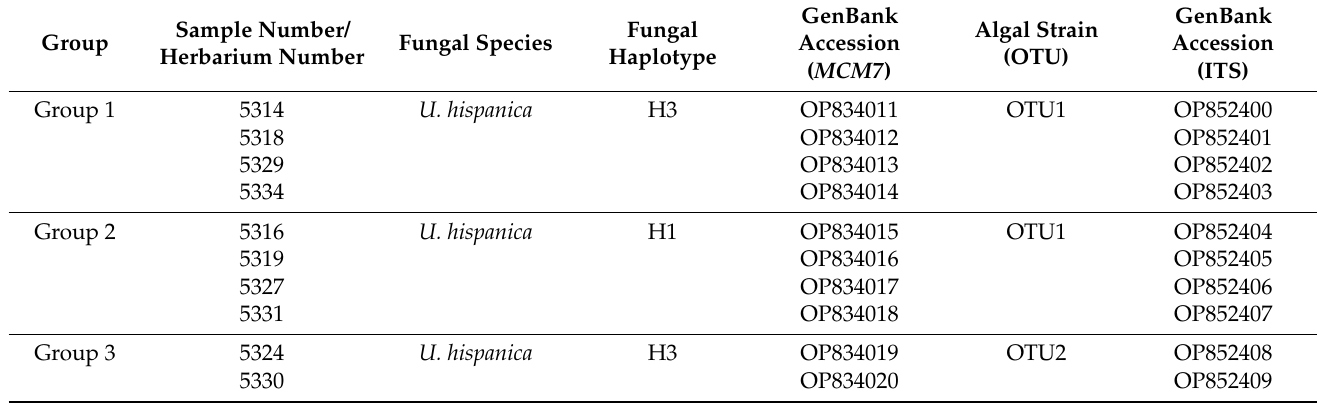
Table 1. Specimens used in this study. Samples are grouped into five groups according to their specific fungal–algal combinations. Designation of fungal haplotypes and algal OTUs follows [30]. Samples are deposited in the Herbarium Senckenbergianum Frankfurt